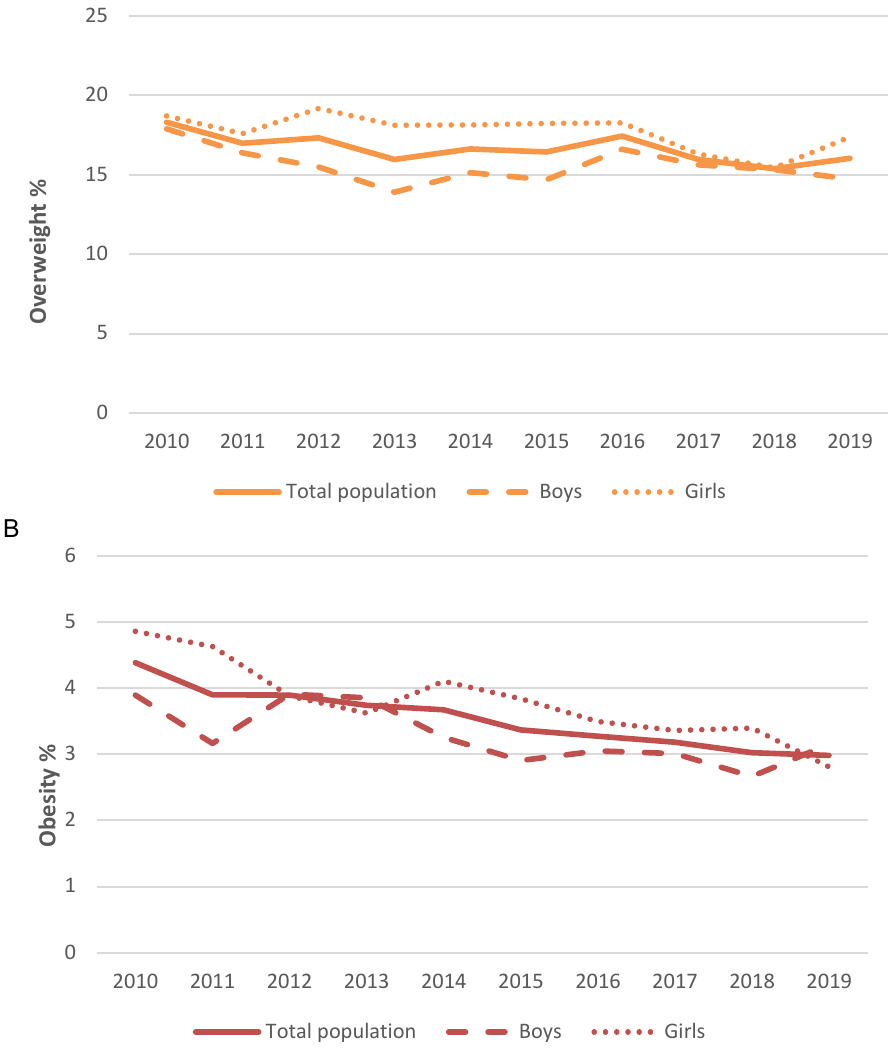
Figure 1. Prevalence of overweight ( A ) and obesity ( B ) among Spanish children by International Obesity Task Force (IOTF) criteria in the 2010–2019 timeframe.